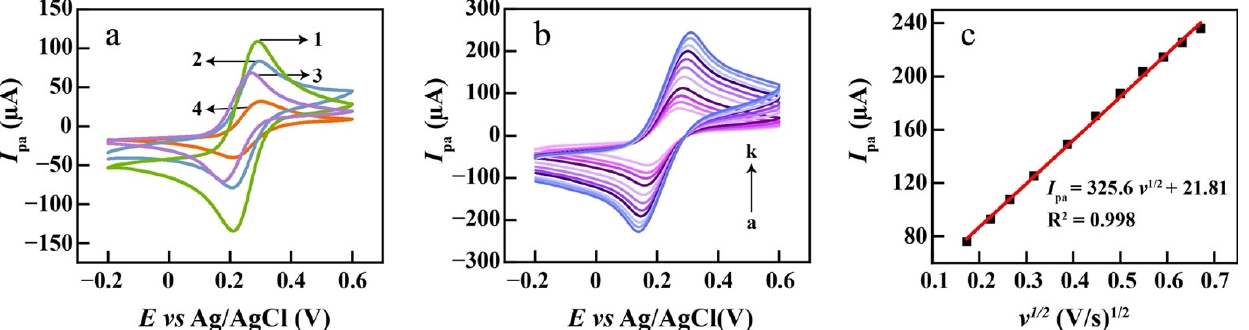
Figure 3. ( a ) CVs of CeO 2 /eGr/GCE in the presence of 5 mM [Fe(CN)6] 3−/4− solution in aqueous 0.1 M KCl. CeO 2 /eGr/GCE (1), eGr/GCE (2), CeO 2 /GCE (3), bare GCE (4); ( b ) CVs of CeO 2 /eGr/GCE in the presence of 5 mM [Fe(CN)6] 3−/4− solution in aqueous 0.1 M KCl at various scan rate (from a to k): 0.03, 0.05, 0.07, 0.1, 0.15, 0.2, 0.25, 0.3, 0.35, 0.4, 0.45 V s −1 . ( c ) The plot of peak currents vs. v 1/2 .